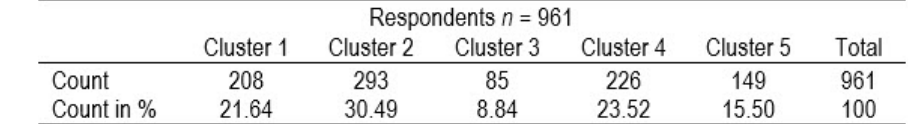
Each group has a different intensity of the measured characteristics. This means that each group uses digital media in a different way. Some elements in particular groups may have similar intensities, but do not have the same usage styles in each area. Detailed characteristics are presented in Table